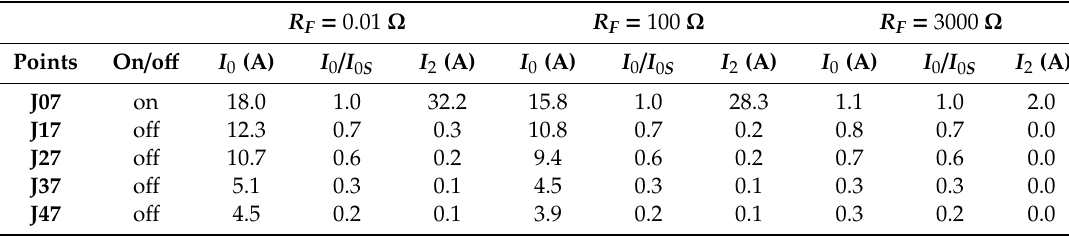
Table 3. Sequence currents at various point during earth fault